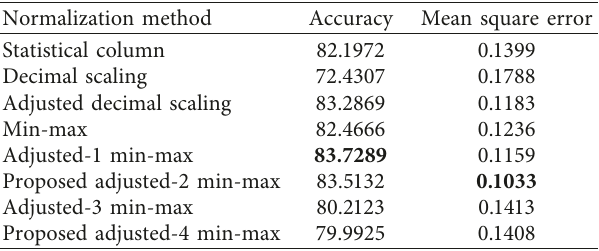
Table 5: Comparative results of prediction efficiency on vertebral column dataset yielded by every tested normalization method.